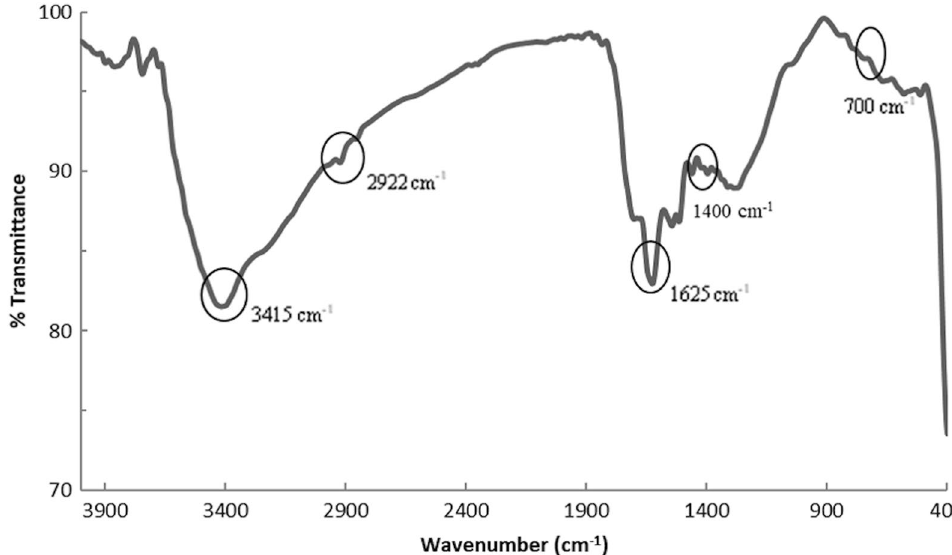
Fig. 2 FTIR spectroscopy of the extracted sepia melanin (SM) powder